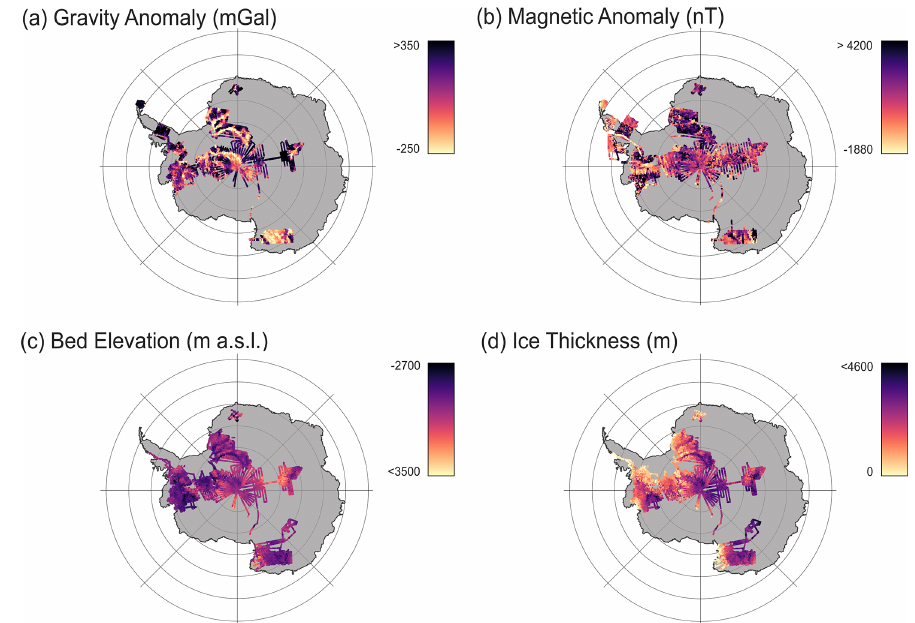
Figure 2. Maps of gravity, magnetic, and radar (bed elevation and ice thickness) point measurements for all surveys published as part of this data release. (a) Gravity anomaly points (in milligal, or mGal), (b) magnetic anomaly points (in nanotesla, or nT), (c) bed-elevation points from radar data (in metres above sea level, or ma.s.l.), (d) ice-thickness points from radar data (metres). In total, this data release consists of 3.62 million gravity, 7.41 million magnetics, and 14.5 million ice-thickness and bed-elevation data points. Note that no correction such as downward continuation has been applied to compile the gravity data shown in (a)